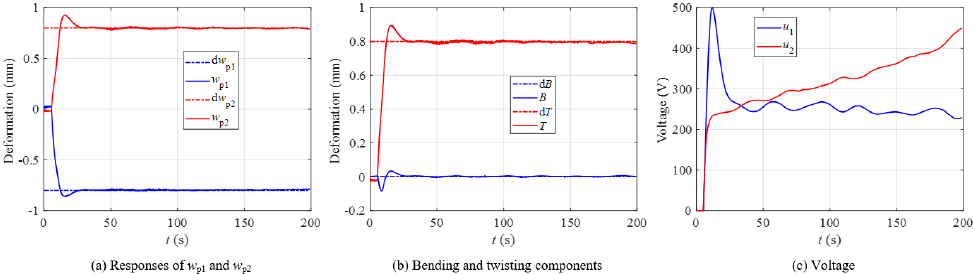
Figure 12. Pure twisting shape control performance. ( a ) The deflection histories of the two measurement points; ( b ) the time histories of B and T ; ( c ) the time histories of the voltages for the two MFC actuators.